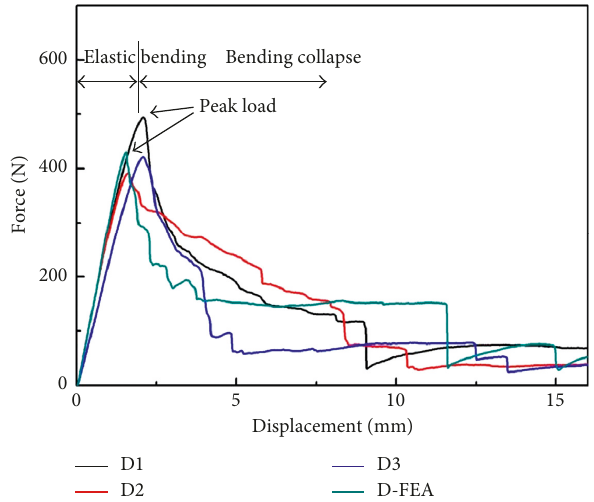
Figure 9: Typical load-displacement curves of specimens in three- point bending tests.